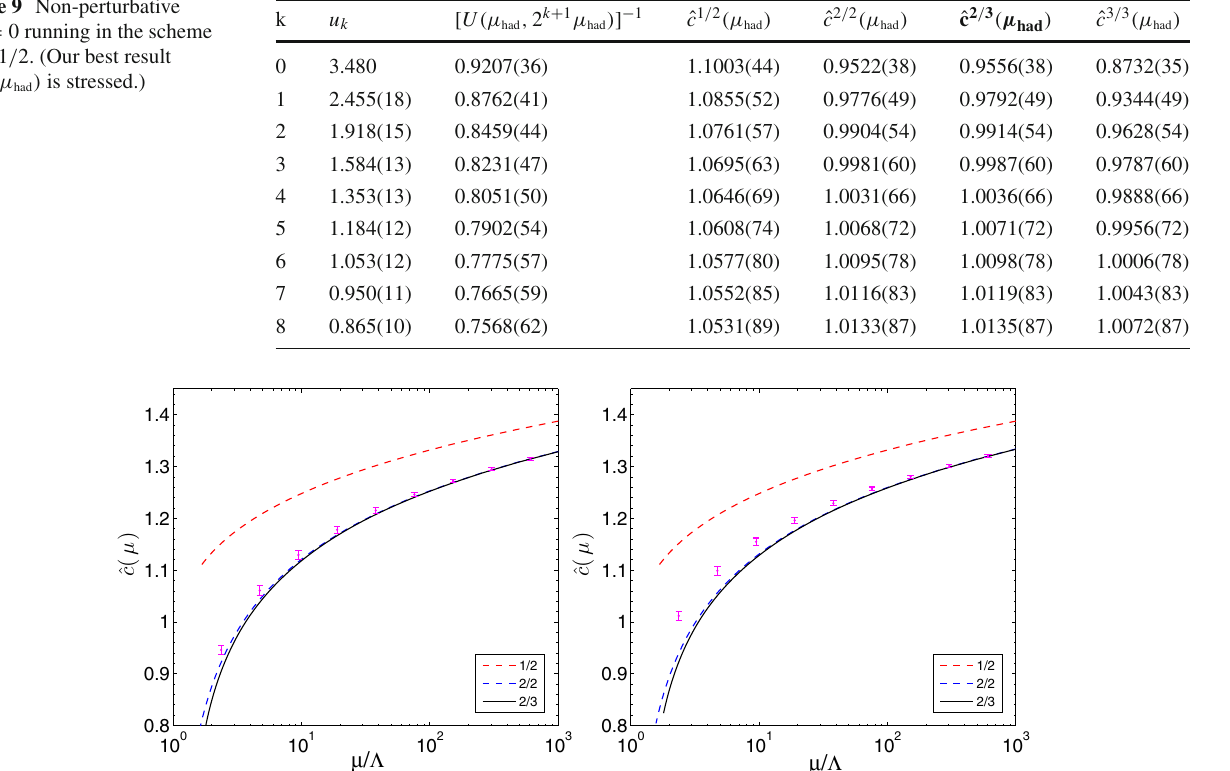
Fig. 6 Running of the tensor current for N f = 0 in the schemes α = 0 (left) and α = 1 / 2 (right), compared to perturbative predictions using